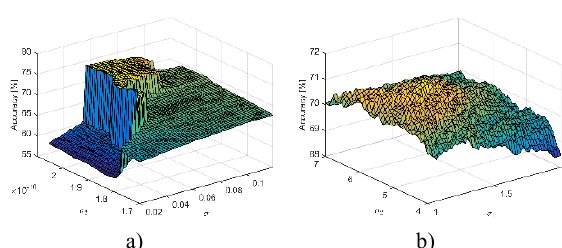
Figure 4 . Grid search of the RBF kernel SVM with a) using the defined feature set and b) using Fast Fourier Transform-based features. Figure 5 . CNN training accuracies per